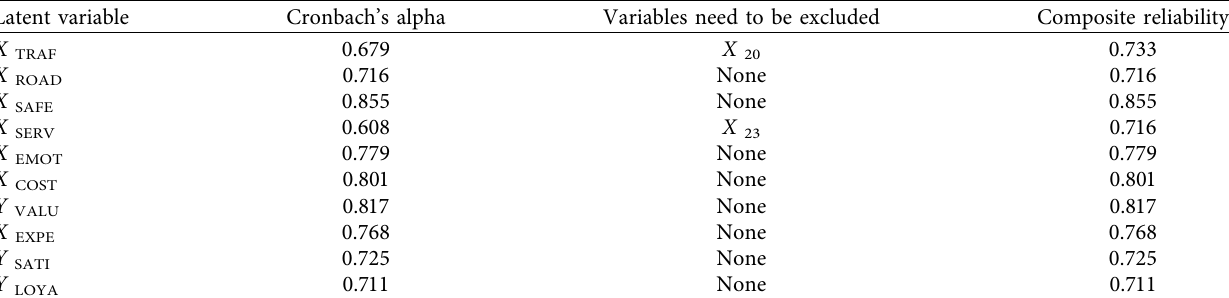
Table 3: Results of survey data reliability analysis.